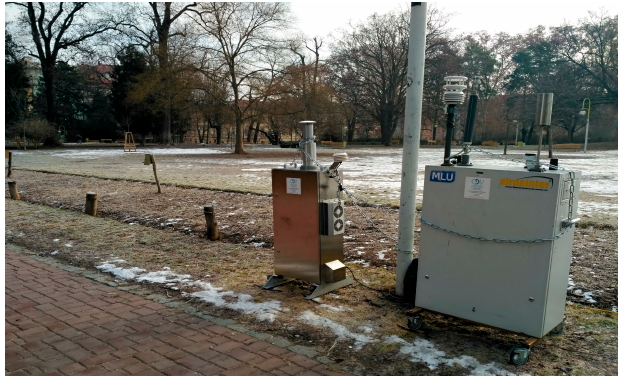
Figure 1. The devices at Tyrš ů v sad.